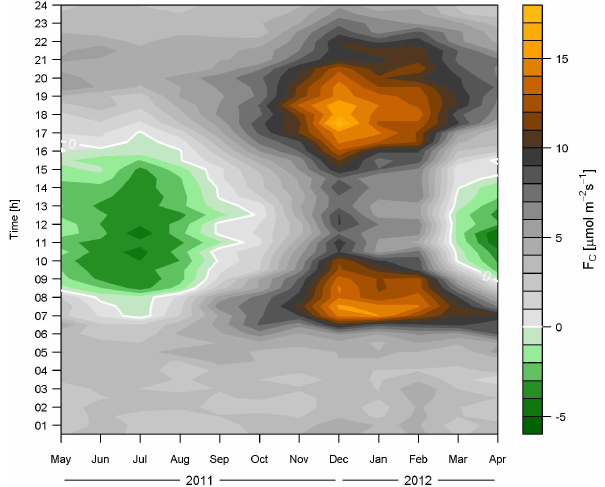
Fig. 12. Temporal variation of monthly ensemble mean carbon fluxes by time of day.